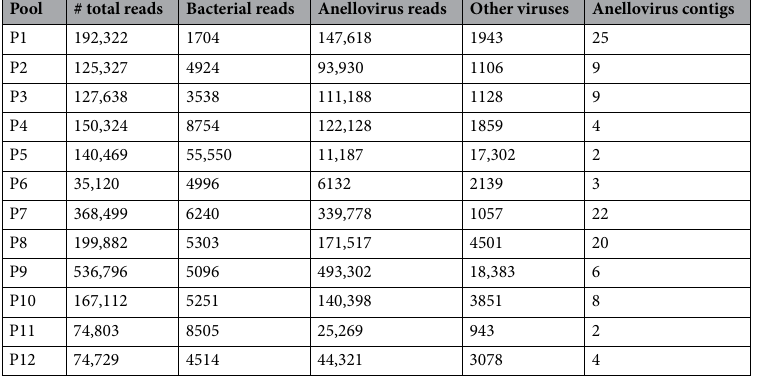
Table 1. Summary of Recentrifuge results for the 12 pools analyzed. For each pool, the total number of reads passing Recentrifuge analyses, and those classified as bacterial, anellovirus and other viruses, are indicated. Last column shows the number of anellovirus contigs over 1.5 kb obtained in the assembling step. For clarity, viral reads from spiked viruses are excluded from